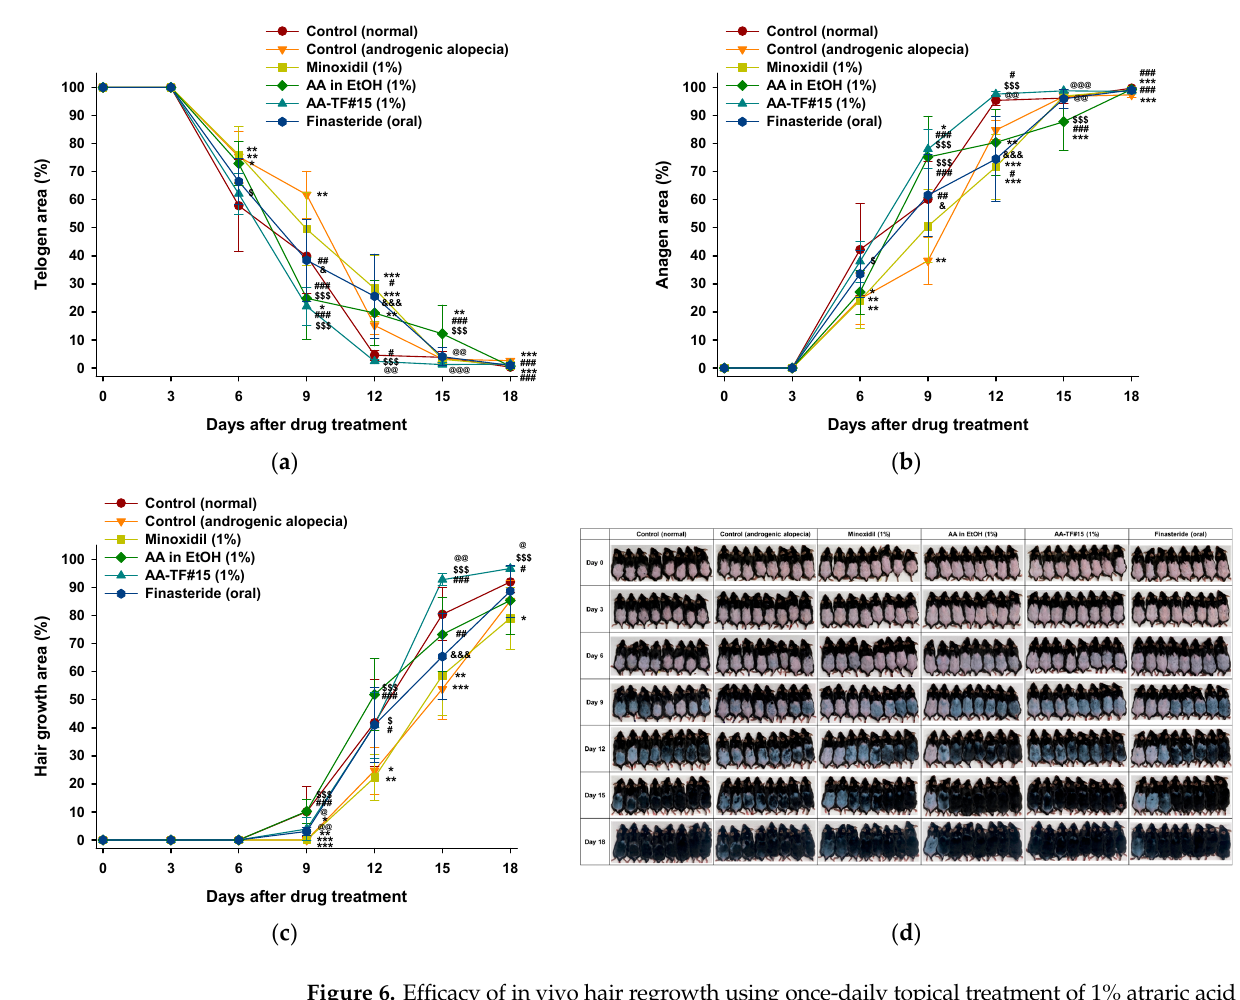
Figure 6. Efficacy of in vivo hair regrowth using once-daily topical treatment of 1% atraric acid (AA) in ethanol (EtOH), AA–TF#15, and 1% minoxidil topical solution, or once-a-day oral administration of finasteride (10 mg/kg) in androgenic alopecia mice: ( a ) Time-course curve of the dorsal skin area showing a pink color (telogen); ( b ) Time-course curve of changes in dorsal skin color from pink to black, indicating hair regrowth (anagen); ( c ) Time-course curve of hair growth on dorsal skin. * p < 0.05, ** p < 0.01, *** p < 0.001 compared to control (normal); # p < 0.05, ## p < 0.01, ### p < 0.001 compared to control (androgenic alopecia); $ p < 0.05, $$$ p < 0.001, compared to minoxidil (1%); @ p < 0.05, @@ p < 0.01, @@@ p < 0.001 compared to AA in EtOH (1%); & p < 0.05, &&& p < 0.001 compared to AA–TF#15 (1%). Values are presented as mean ± SEM ( n = 8 for each group); ( d ) Representative photographs of mouse dorsal skin showing hair regrowth at 0, 3, 6, 9, 12, 15, and 18 days after treatment.